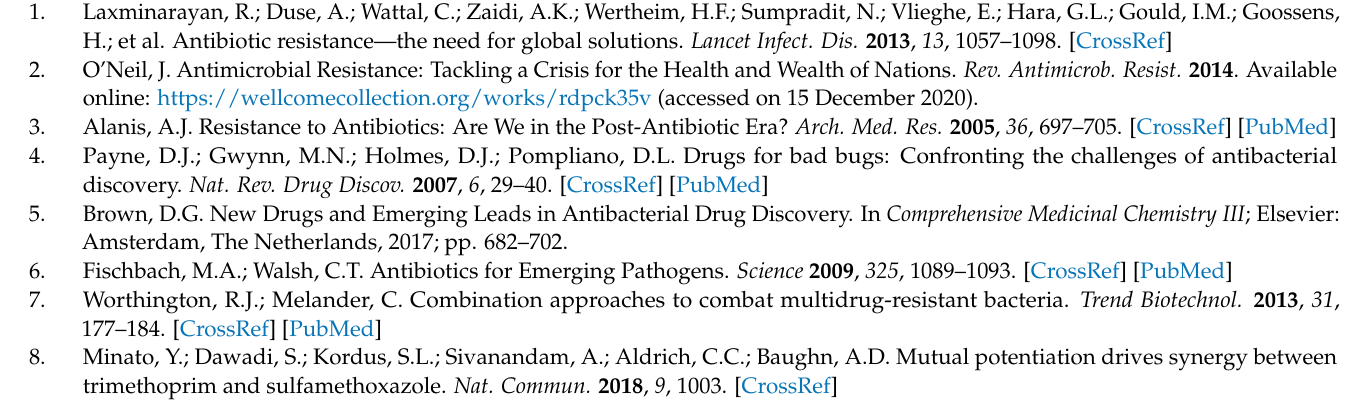
Table S2: Oxacillin potentiation with melittin in S. aureus